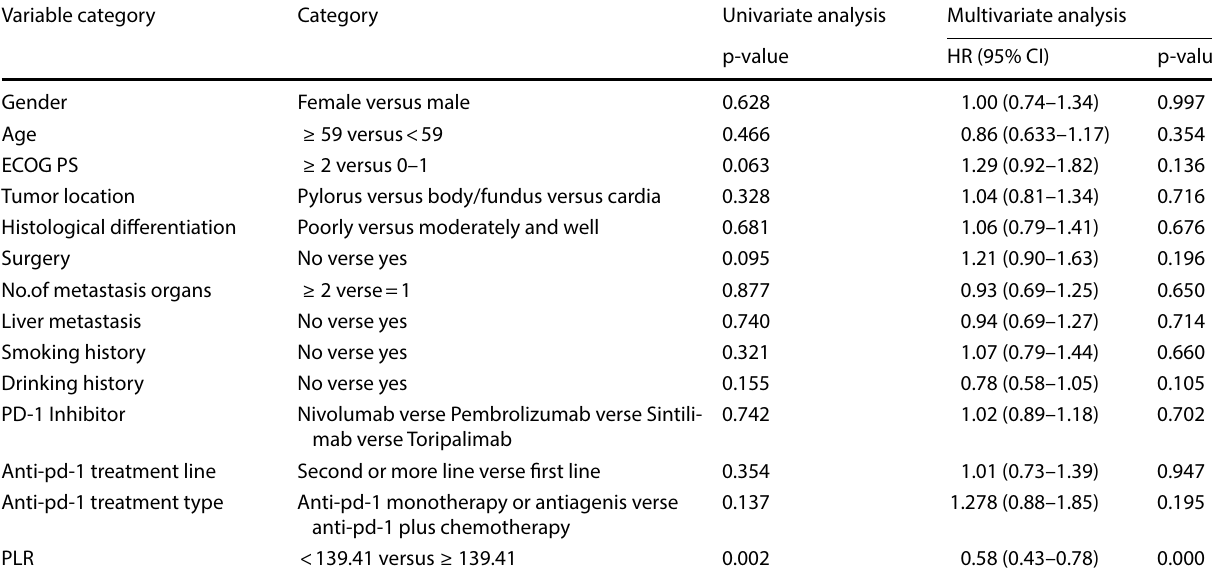
Table 4 Univariate analysis and multivariate analysis of progression free time (PFS)